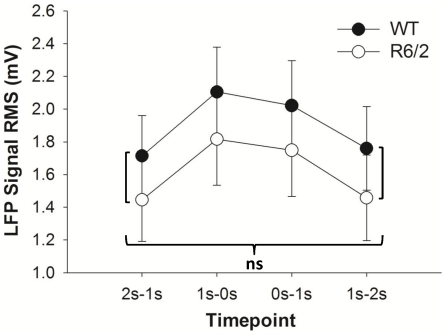
LFP signal amplitude around the choice points.Only a significant time effect was observed. Post-hoc analysis of the main effect of time revealed that all of the Bonferroni-corrected pairwise comparisons for the RMS values at the different time points were significant, with the exception of the comparison between 2-1s prior and 1-2s after the choice point, marked ns for not significant. Data are averaged across all choice point crossings and animals within each group; error bars reflect one standard error of the mean.